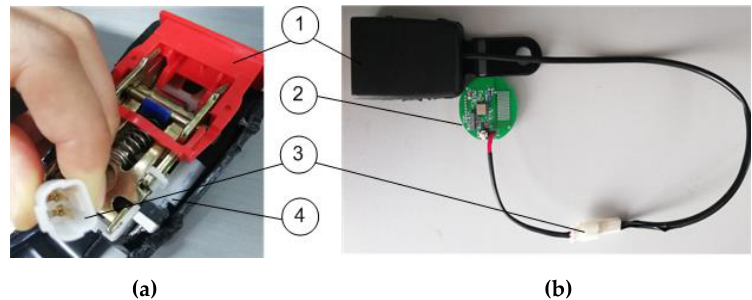
Figure 3. ( a ) A seatbelt buckle; ( b ) the measurement system: (1) buckle joint, (2) sensor node, (3) connector between the sensor node and the buckle, (4) trigger